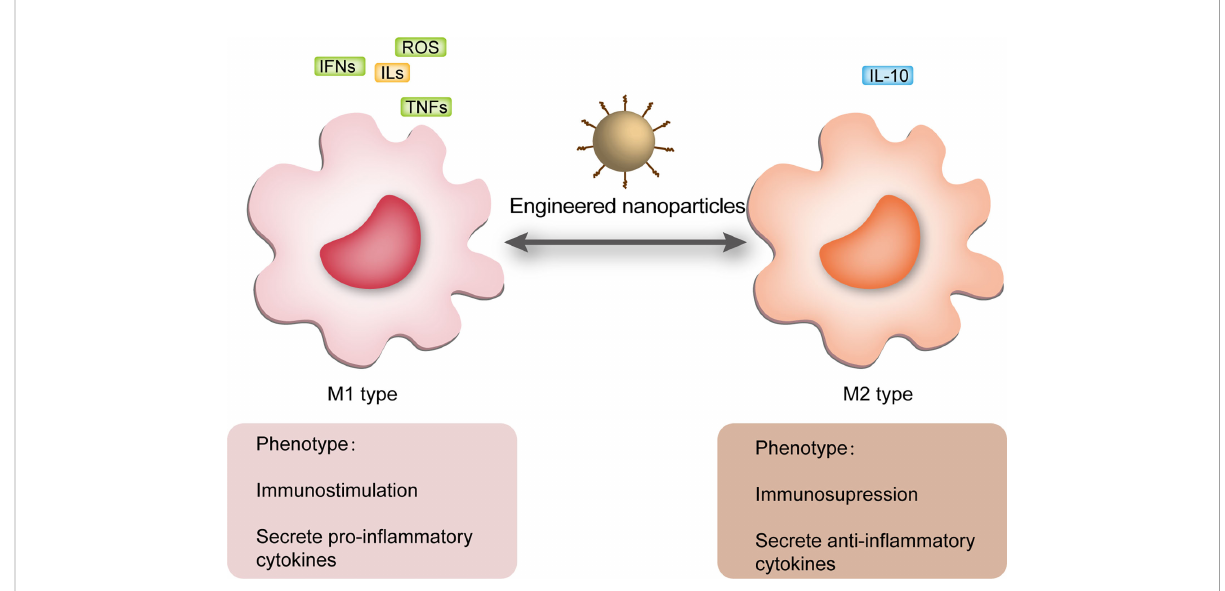
FIGURE 3 NPs regulated macrophage polarization. M1 macrophages usually act in the sepsis cytokine storm state and release a large number of pro- in fl ammatory mediators, including ROS, IFNs, ILs and TNFs, while M2 macrophages usually appear in the immune paralysis phase and secrete anti-in fl ammatory mediators, the most characteristic of which is IL-10. During periods of in fl ammatory overstimulation, sustained release of pro-in fl ammatory mediators from M1 induces damage to the organism, while massive activation of M2 macrophages during periods of immune paralysis increases the risk of secondary infection. NPs can regulate macrophage polarization in different periods of sepsis improving its prognosis. NPs, nanoparticles; ROS, reactive oxygen species; ILs, interleukins; IFNs, interferons; TNFs, tumor necrosis factors.